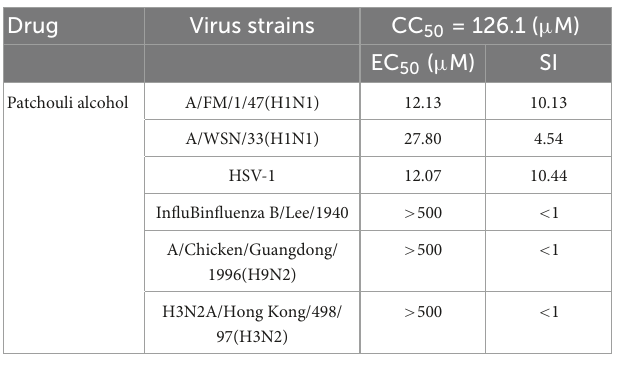
TABLE 2 Patchouli alcohol inhibition of several influenza virus strains and HSV-1. Drug Virus strains